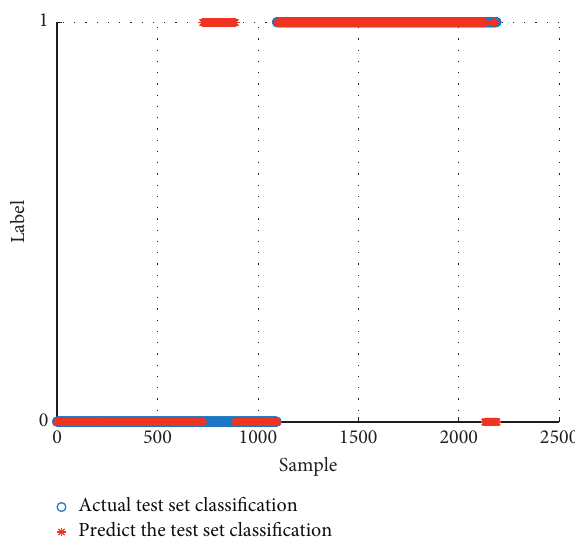
Figure 15: Mechanical failure comprehensive simulation experiment bearing inner ring failure results based on